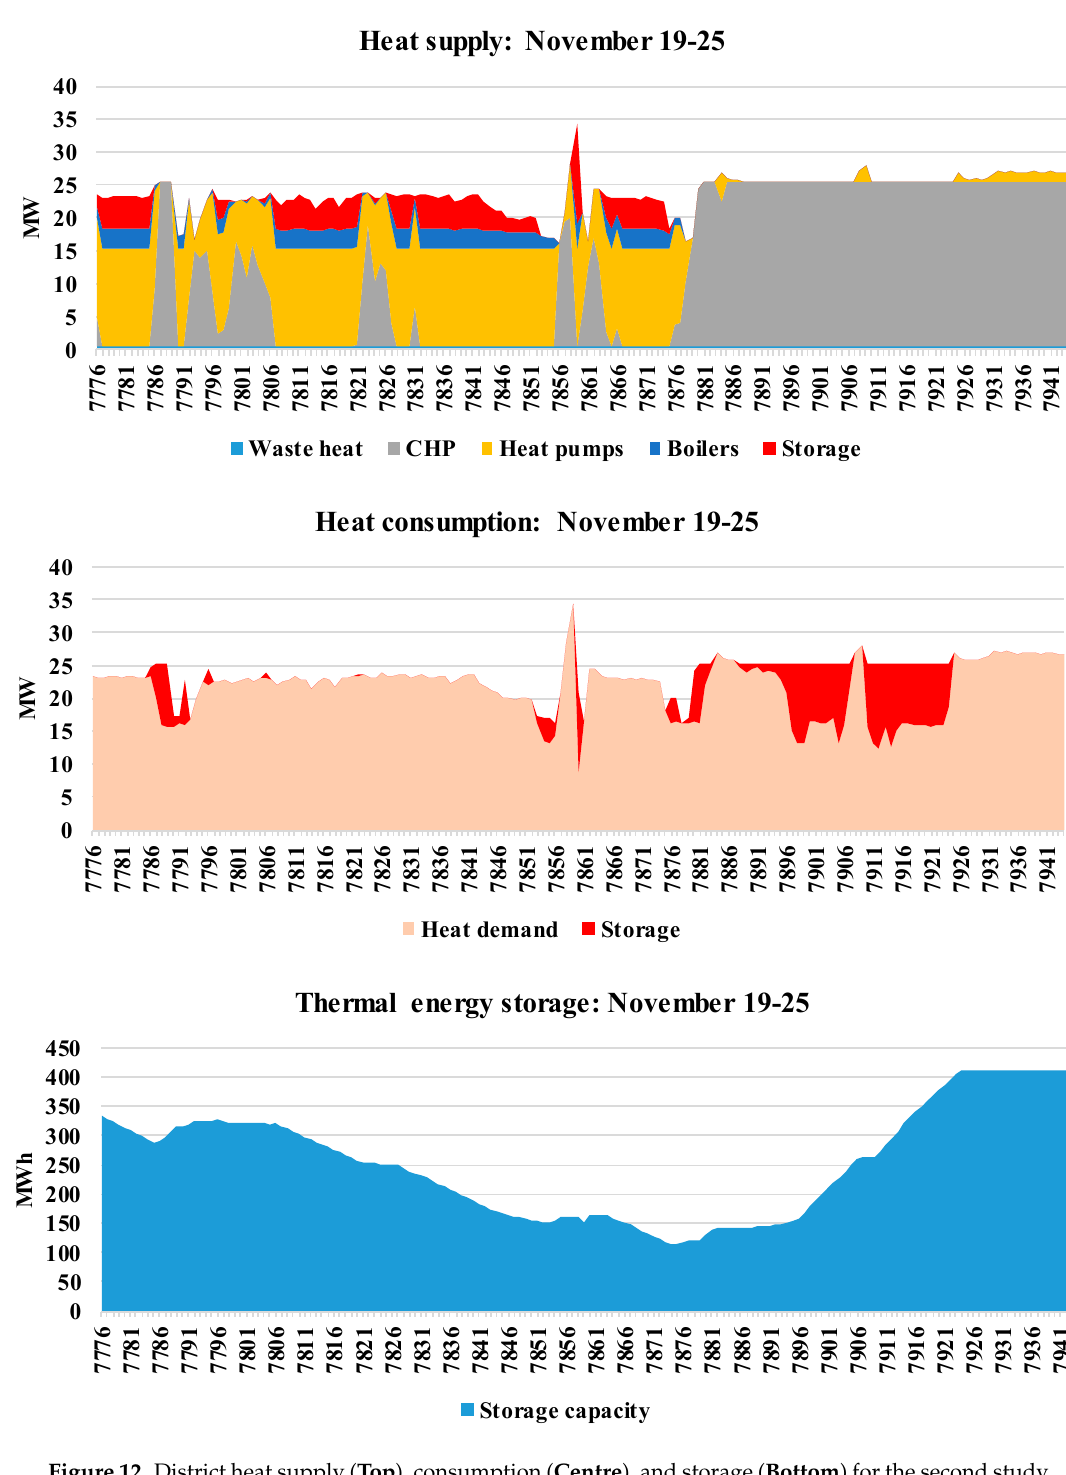
Figure 12. District heat supply ( Top ), consumption ( Centre ), and storage ( Bottom ) for the second study period: 19–25 November. High power requirements toward the end of the week led to oversupply of heat originating from CHP plants. Thermal storage levels increased toward the end of this study period accordingly. Heat pumps use early in the week occurred at times of relatively higher variable RE production.